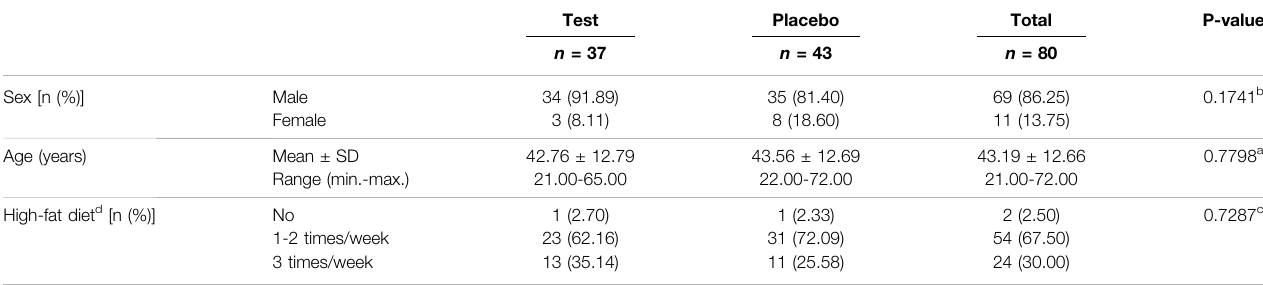
TABLE 2 | Demographic characteristics of participants prior to treatment (PP